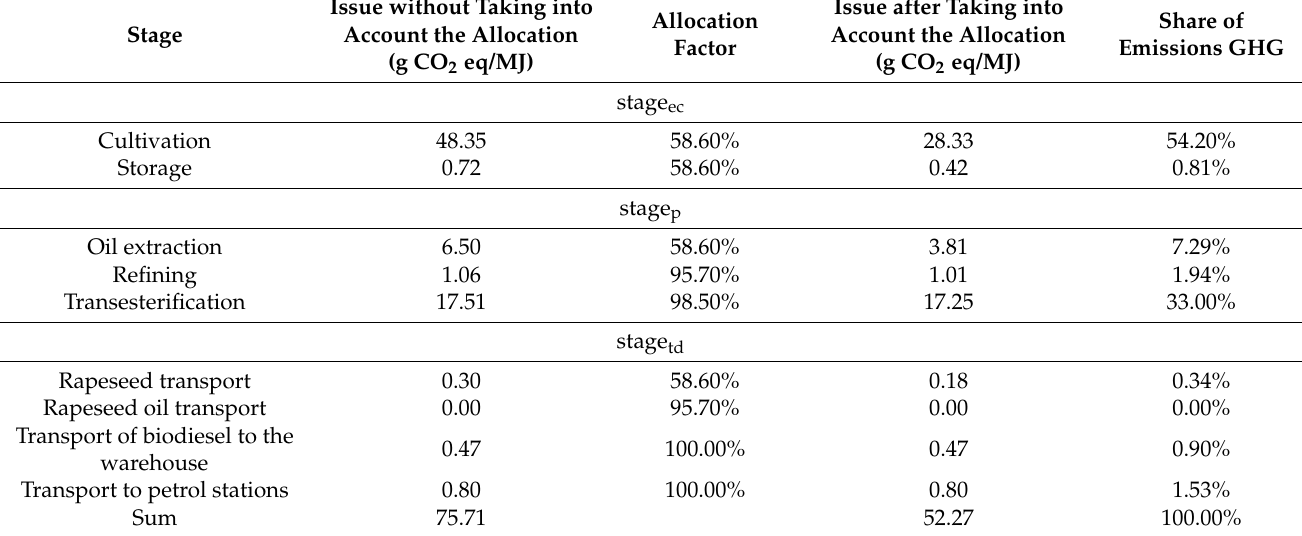
Table 16. GHG emissions in the biofuel life cycle based on financial